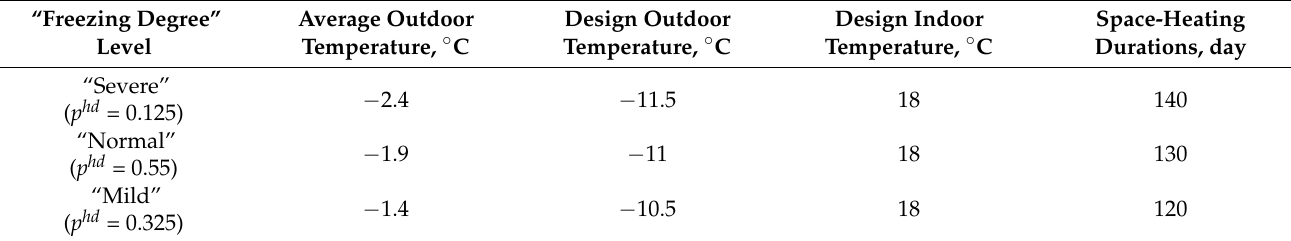
Table 1. Modelling parameters for NCEs method